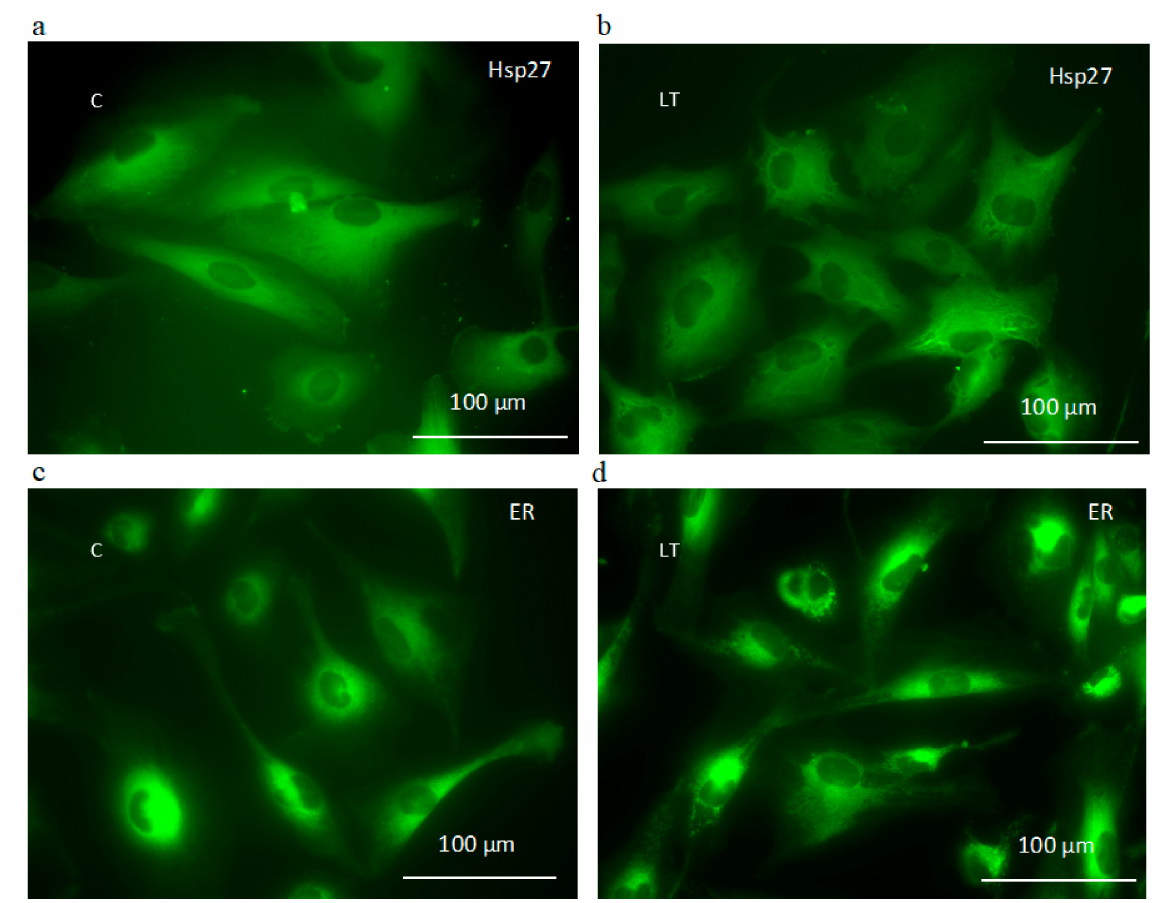
Figure 9. Localization of Hsp27 detected immunocytochemically with specific anti-Hsp27 antibodies ( a , b ) and ER structure after staining with DiOC 6 (3) ( c , d ) in control ( a , c ) and LY294002 (L) with temozolomide (T) treated ( b , d ) MOGGCCM cells.